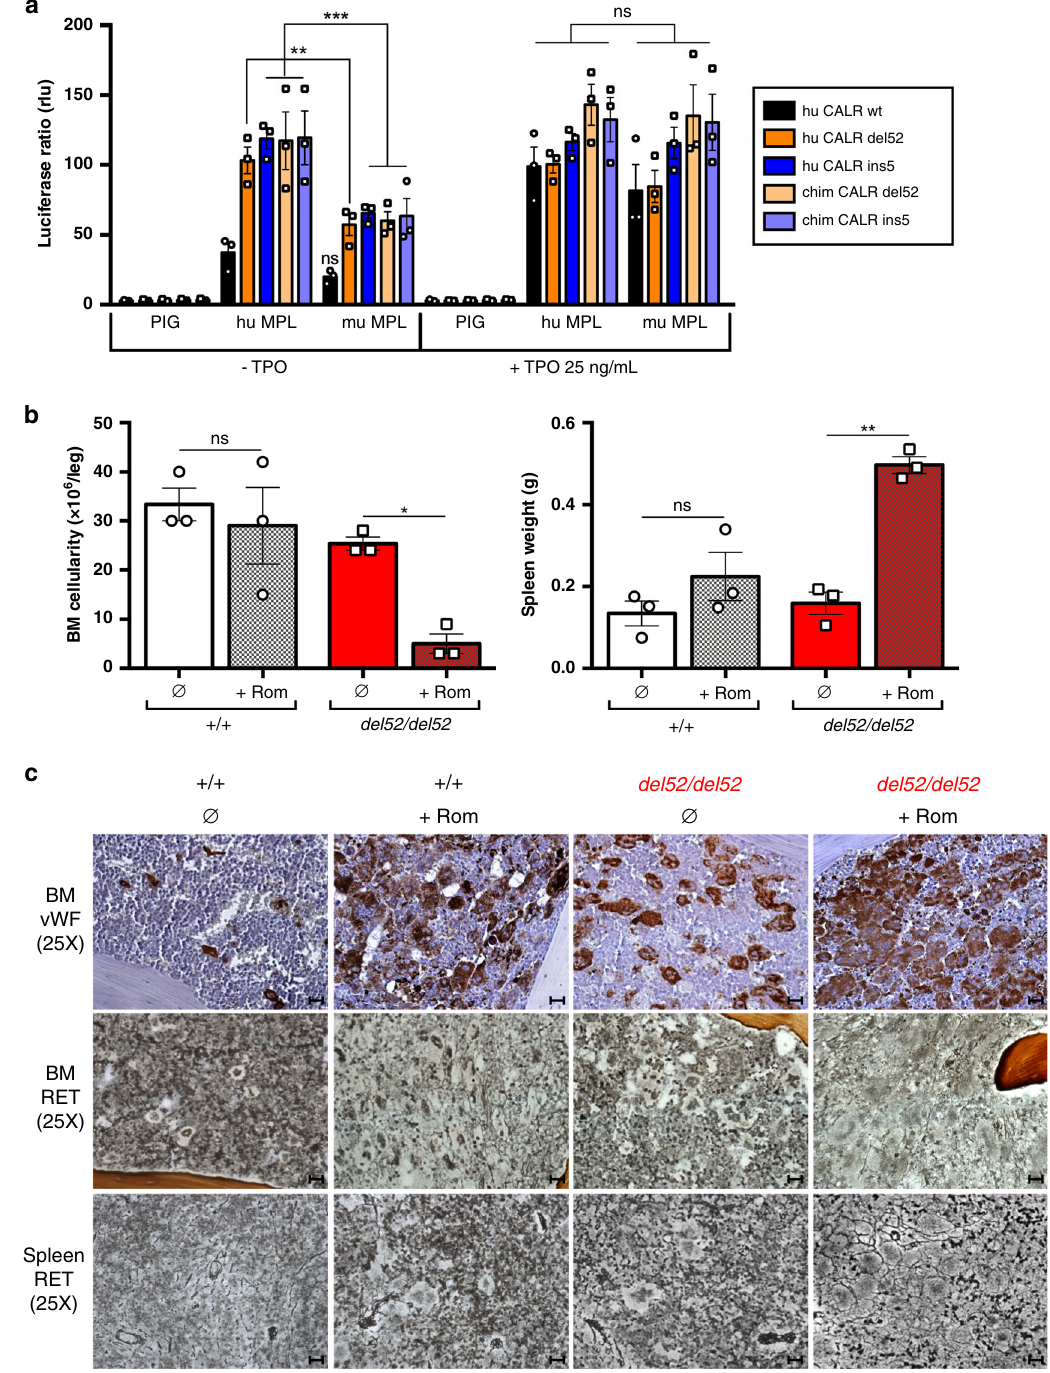
Fig. 5 Degree of activation of MPL/JAK2/STAT determines the phenotype. a The γ 2A cells were transfected to express JAK2, mu MPL, hu MPL or an empty vector (PIG) and equal amounts of either the hu CALR wt (black), del52 (dark orange) or ins5 (dark blue) or the chim CALR del52 (light orange) or ins5 (light blue), as indicated. STAT5-dependent transcriptional activity with or without TPO was measured 24 h after transfection by the dual fi re fl y luciferase system with Spi-Luc reporter (STAT5 response elements) and renilla pRL-TK reporter with constitutive expression, as an internal control. Shown are means ± SEM of three independent experiments in triplicate. Signi fi cance was assessed using Tukey ’ s multiple comparison test (** p = 0.026; *** p = 0.0004 (hu CALR ins5), 0.0001 (chim CALR del52), 0.0002 (chim CALR ins5); ns not signi fi cant). b BM cellularity and spleen weight of 1 month post- tamoxifen del52/del52 KI mice (red) and wild-type ( + / + ) littermates (white) treated with romiplostim ( + Rom, hatched histograms) or not ( ∅ , solid histograms). Data are means ± SEM ( n = 3 different mice) and signi fi cance of + Rom to ∅ condition was assessed using a two-sided parametric paired t -test: * p = 0.0198; ** p = 0.0017; ns: not signi fi cant. Source data are provided as a Source data fi le. c BM and spleen were examined after vWF immunostainning and RET staining. Images were obtained using a DM2000 Leica microscope and a DFC300FX Leica camera with Leica Application Suite v.2.5,OR1 acquisition software (×25 magni fi cations). Scale bars represent 50 μ m. Similar results were obtained with analyzing three independent mice for each